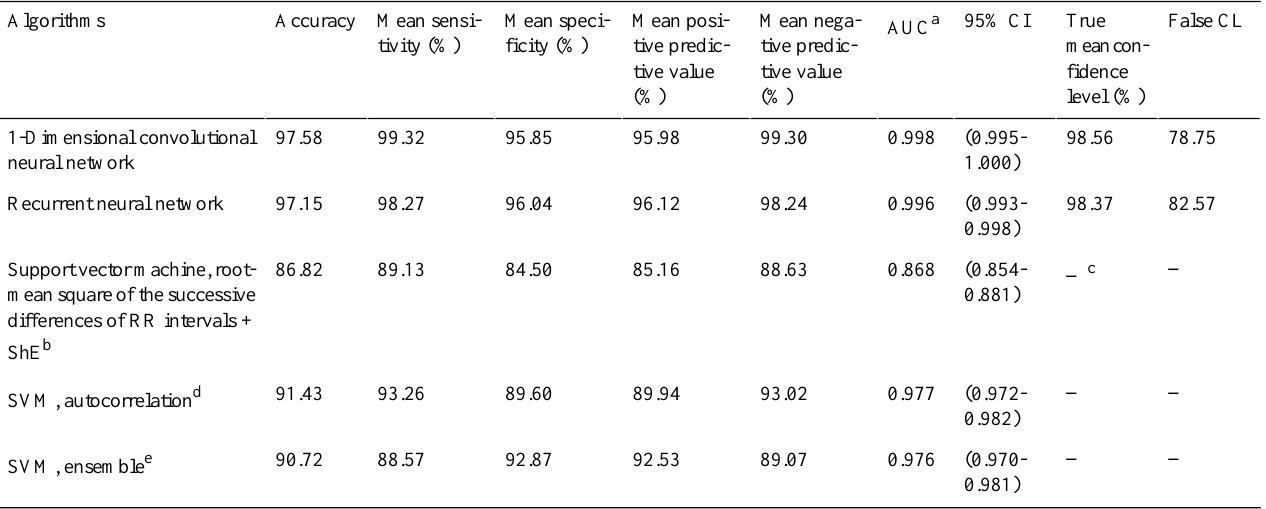
Table 2. The diagnostic performance of various algorithms for classifying photoplethysmography samples of atrial fibrillation and sinus rhythm after electrically cardioverted